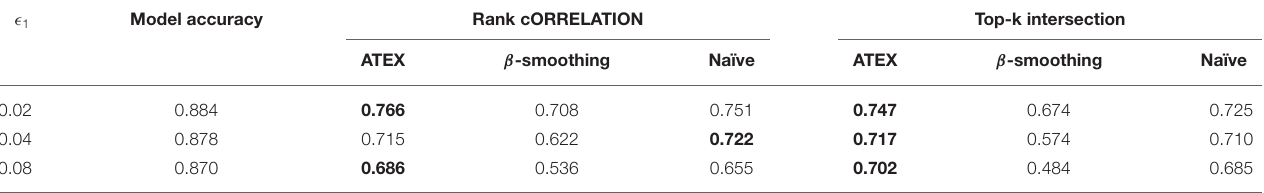
TABLE 1 | Defense against untargeted explanation manipulation on FashionMNIST.